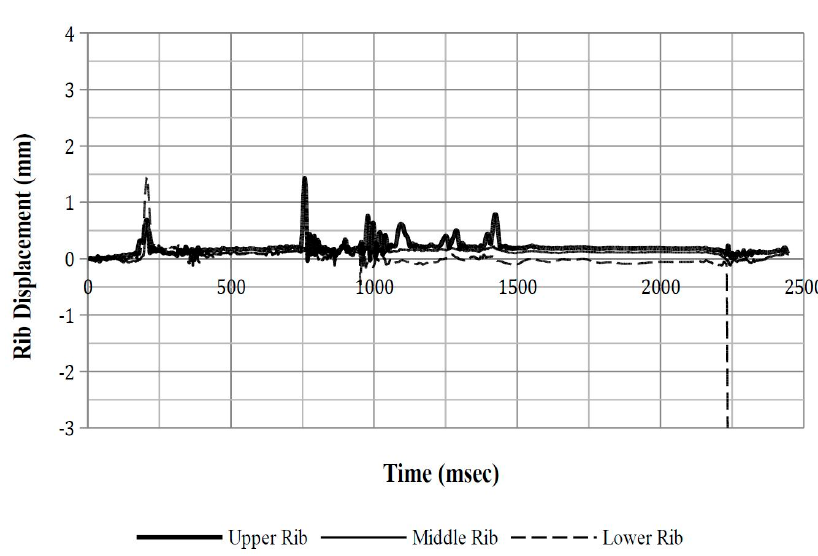
Figure A9. ATD Position 8 rib displacement.